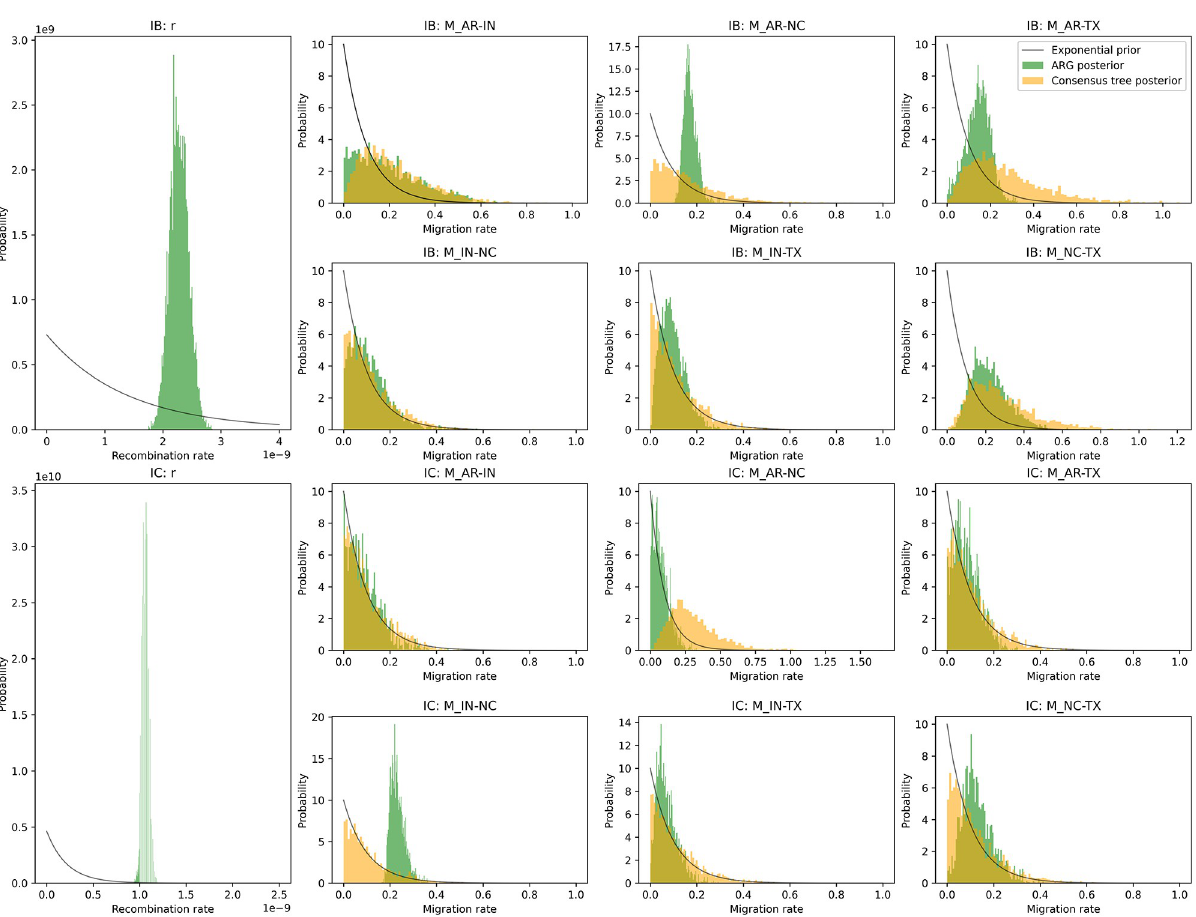
Fig 8. The prior and posterior distributions of demographic parameters estimated from either the full ARG or a single consensus tree for lineages IB and IC. For lineage IB, the mean value of exponential prior of recombination rate is 1.37e-09, and the mean value of exponential prior of migration rates is 0.1; For lineage IC, the mean value of exponential prior of recombination rate is 2.17e-10, and the mean value of exponential prior of migration rates is 0.1. Note that we cannot estimate r from the consensus tree so only the posterior distribution estimated from the ARG is